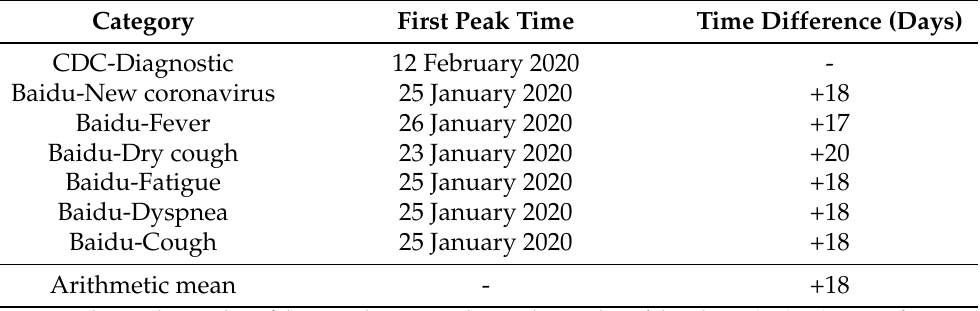
Figure 1. The number released by the CDC and Baidu index data based on keyword searches. ( a ) represents the number of newly diagnosis released by the CDC. ( b – g ) represent the Baidu index data based on keywords “New coronavirus”, “Fever”, “Dry cough”, “Fatigue”, “Dyspnea”, “Cough” respectively. ( h ) represents the death toll released by the CDC. CDC = Centers of Disease Control. Table 2. Comparison of peak time between Baidu Index data based on different keywords and CDC new diagnostic